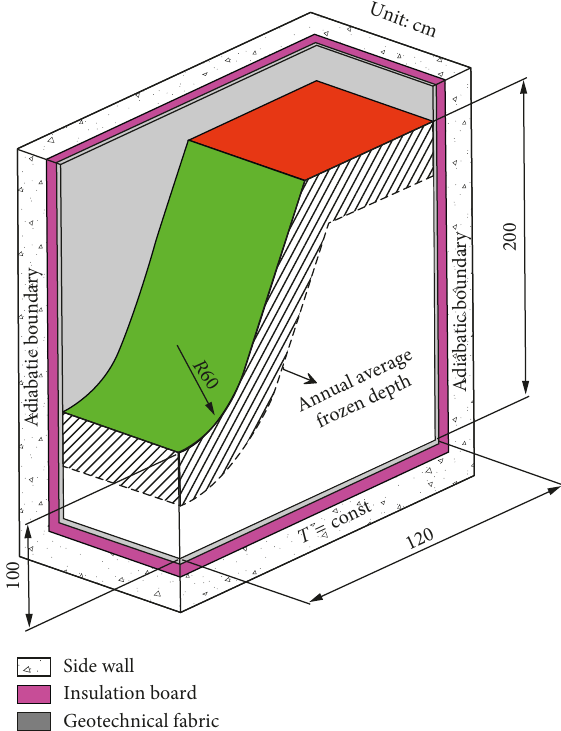
Figure 2: Schematic diagram for the U-shaped irrigation